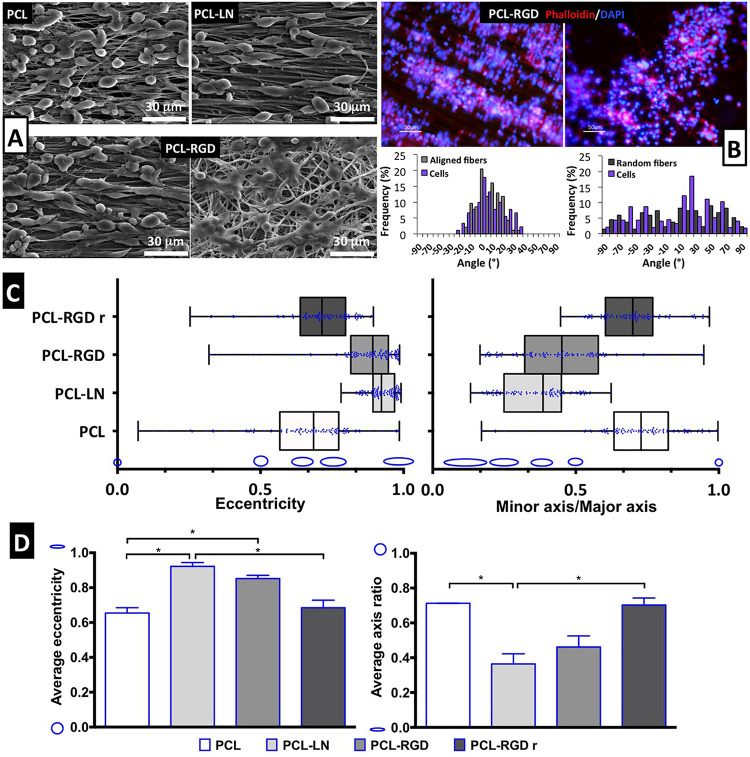
Evaluation of cell morphology and organization after CGR8-NS cell expansion on the PCL nanofibers. (A) SEM images after 3 days of expansion; scale bar 30 μm. (B) Image of cellular cytoskeleton staining with rhodamine phalloidin in PCL-RGD and PCL-RGDr, with respective histograms of cell alignment versus fiber arrangement; scale bar 50 μm. (C) Box-and-whisker plot for eccentricity (E = 0, perfect circle; E = 1, elongated shape) and aspect ratio (AR = 1, perfect circle; AR = 0, elongated shape) for cellular elongation quantification. The box boundaries represent the 25th and the 75th percentile; the straight line inside is the median. A minimum of 50 cells were measured. (D) Average values for eccentricity and aspect ratio. The shape corresponding to discrete eccentricity and axis ratio values is illustrated on the y axis. Error bars represent standard error of the mean; *p < 0.05 (n = 2).